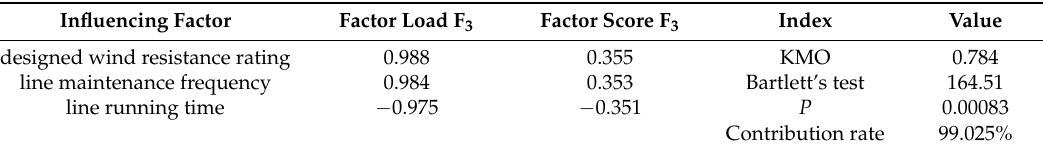
Table 4. Factor analysis of wind resistance.